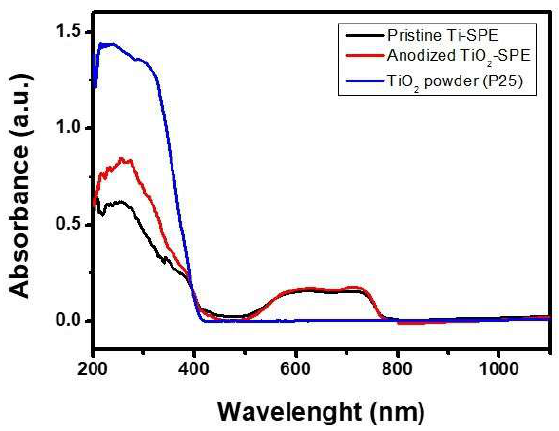
Figure 4. UV-Vis diffuse reflectance spectra of bare Ti-SPE and modified TiO 2 -nanoporous SPE. The spectrum of reference, TiO 2 Degussa P25, is also shown.